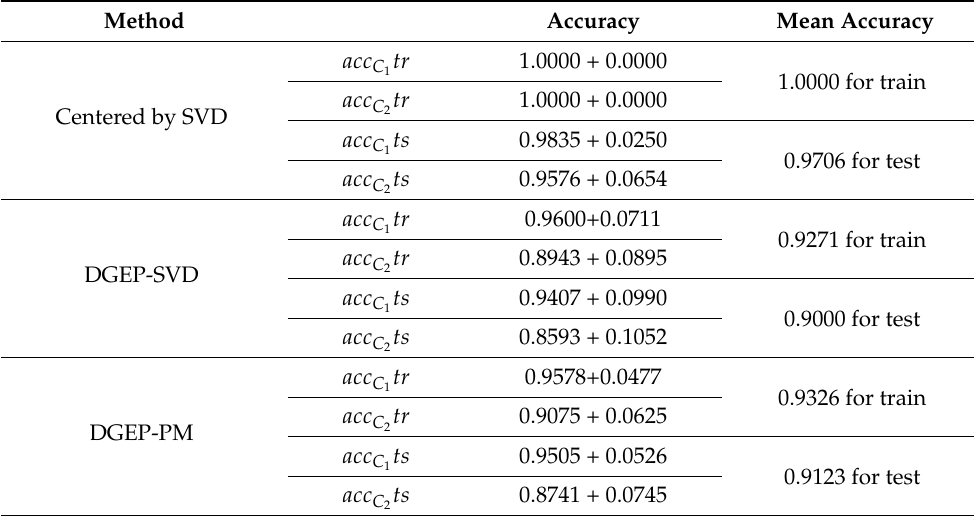
Table 2. Classification accuracy of GSE2187 data in FDA: training accuracy of C i ( acc C ts ). accuracy of C i ( acc C i